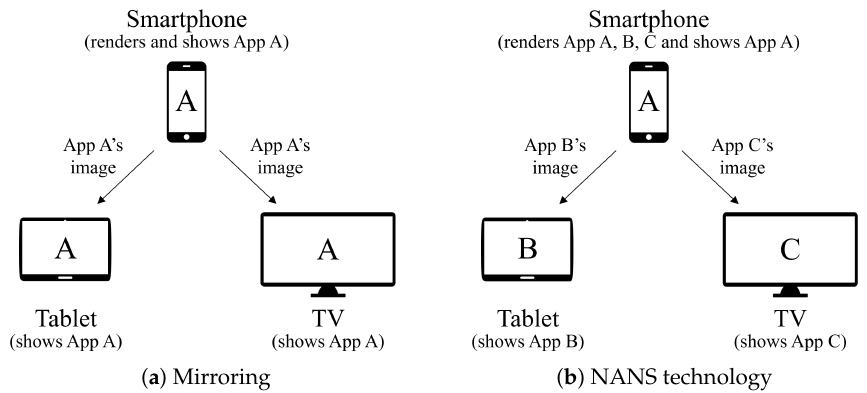
Figure 1. Feature comparison between Mirroring and NANS (N-App N-Screen)